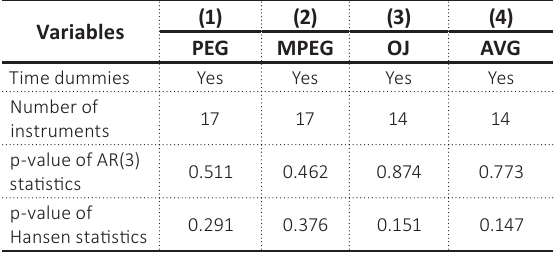
Note: Columns 1-4 of Table 3 present the regression results that examine the relationship between holding variables and the three ICC models incorporating the second polynomials of the variables of interest, CORP, INST, and FOR. The models are estimated using a two-step system GMM with time dummies. The firm-level clustered standard errors are